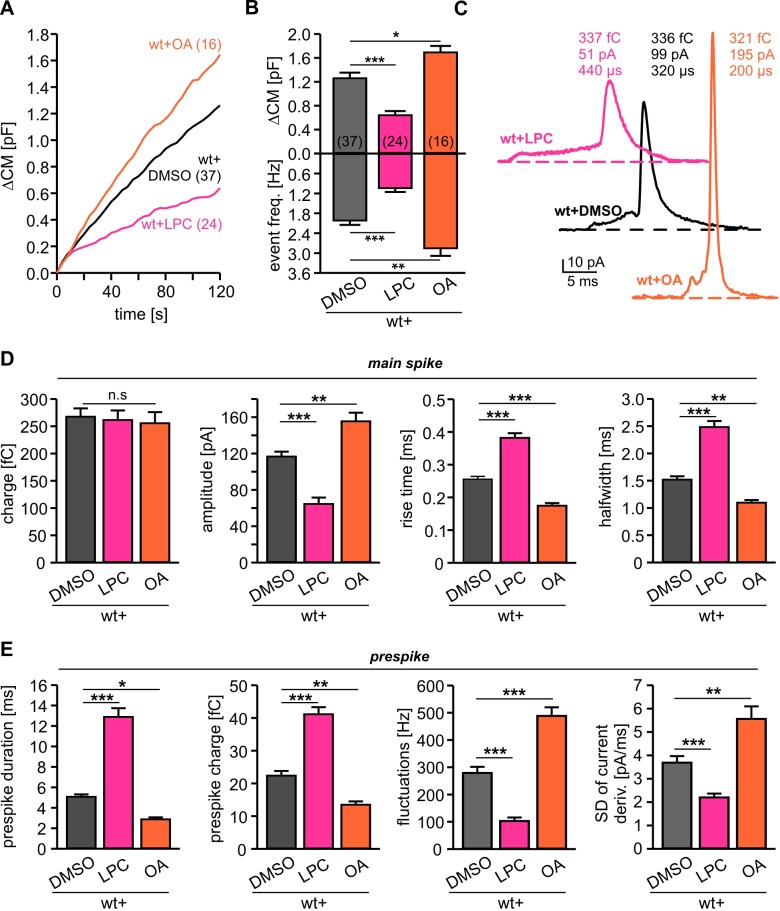
Intracellular application of LPC and OA oppositely affects total membrane fusion and fusion pore kinetics.(A) Mean capacitance changes in response to stimulus for the indicated groups. (B) Intracellular LPC reduces and intracellular OA enhances total ∆CM response (top) and the corresponding amperometric event frequency (bottom). Data are averaged from the indicated number of cells. (C) Exemplary amperometric events with similar charge but altered release kinetic profile for wt+DMSO (control), wt+LPC and wt+OA. (D) Intracellular LPC decelerates the spike waveform by lowering the amplitude, prolonging the rise time and half width (without affecting the spike charge), whereas OA accelerates the current transient. (E) Intracellular LPC and OA oppositely affect the indicated parameters of the prespike phase. Values are given as mean of median determined from the indicated parameter’s frequency distribution for each cell. Data were collected from cells/events measured for wt (37/4023), wt+LPC (24/1674), wt+OA (16/2104). Only cells with >20 events were considered. Data are represented as mean ± SEM. *p<0.05, **p<0.01, ***p<0.001, one-way analysis of variance followed by Tukey-Kramer post test.